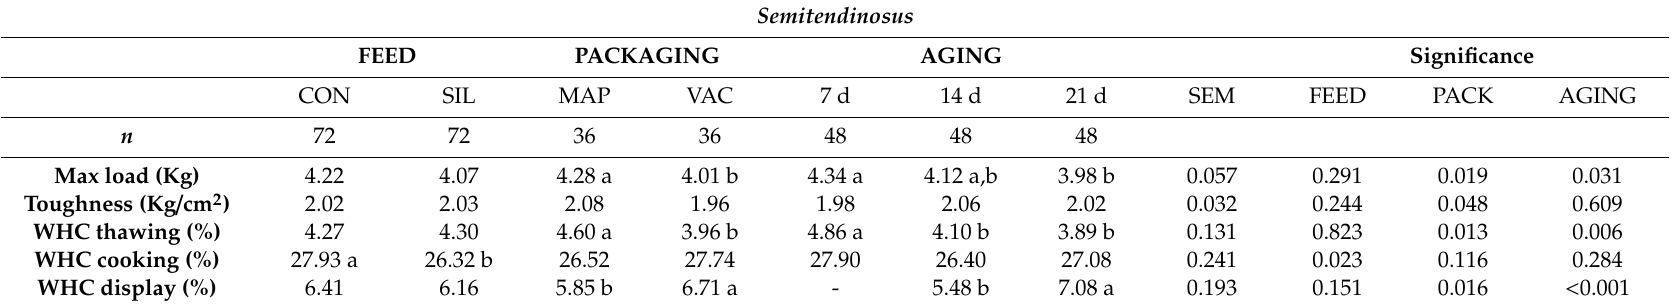
Table 6. E ff ect of feeding (concentrate (CON) vs. 70% maize silage + 30% concentrate (SIL)) and packaging (vacuum (VAC) and modified atmosphere (MAP)) and aging (7, 14 and 21 days) on texture parameters (maximum load and toughness), water holding capacity (WHC) of thawing, cooking and display of Longissimus thoracis muscle of meat from Avileña-Negra Ib é rica breed and significance of e ff ect of feeding (FEED), packaging (PACK) and aging (AGING).